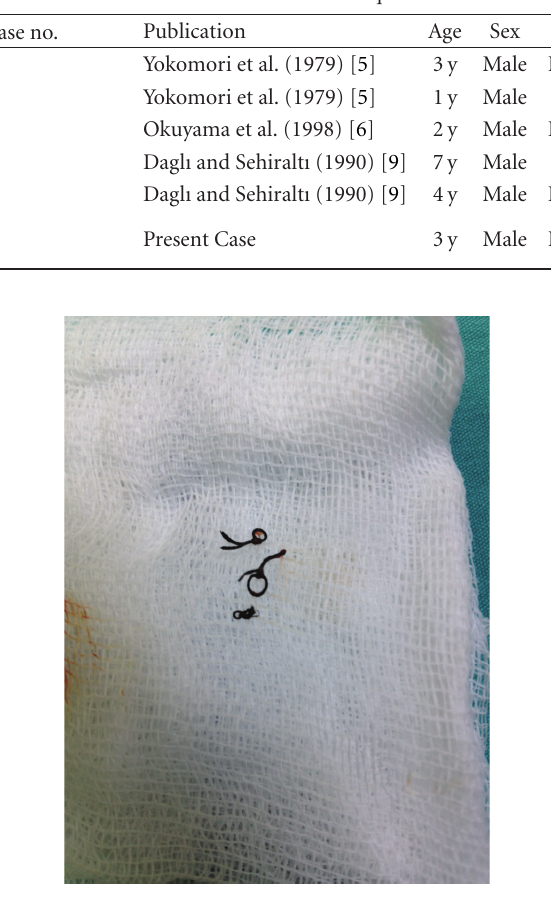
Figure 1: The view of foreign body as material of